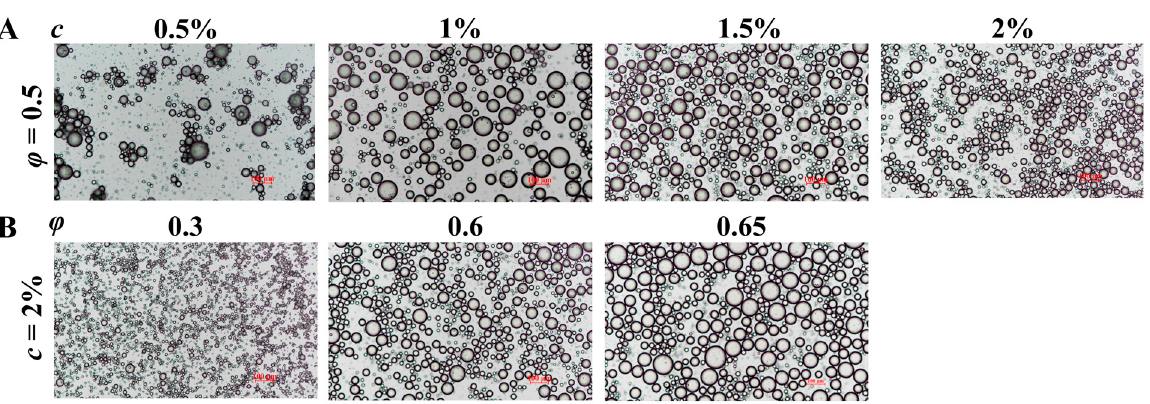
Figure 6. Optical microscopic images of Pickering emulsions stabilized with different c (0.5–2 wt%) of the LF–FD complexes at different ϕ (0.3–0.65): ( A ) ϕ = 0.5; ( B ) c = 2 wt%. The scale bars within the figures are 100 µ m in length.